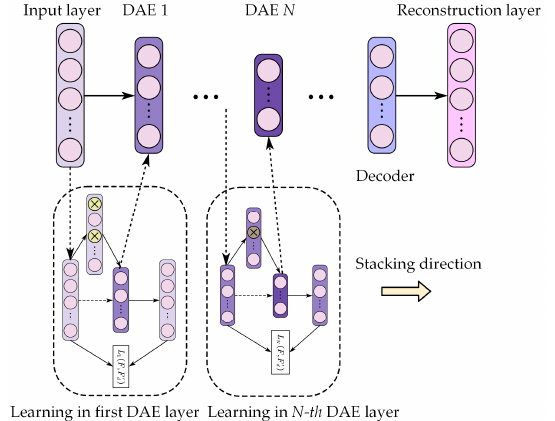
Figure 2. Architecture of the denoising auto-encoder.